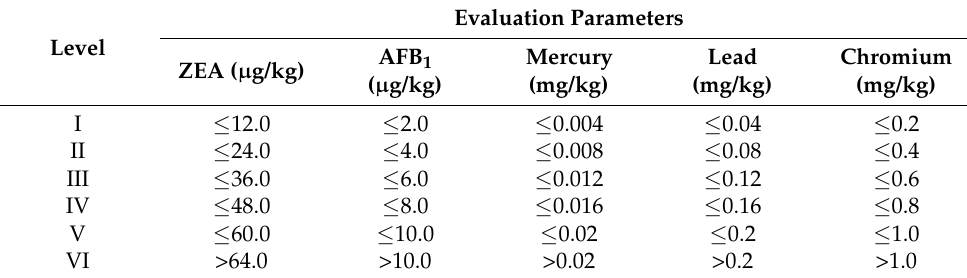
Table 3. Rice risk evaluation standards.